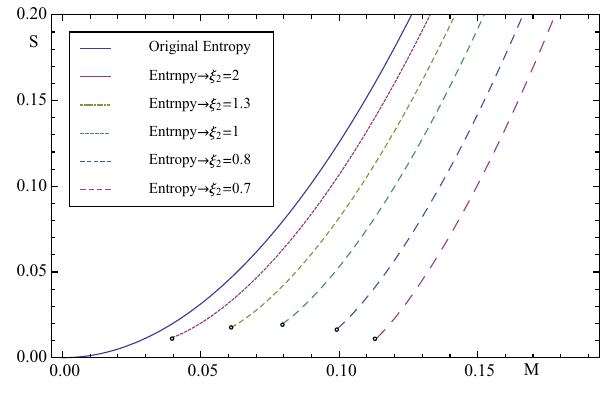
Fig. 3 The LIV-DR induced black hole entropy versus its mass